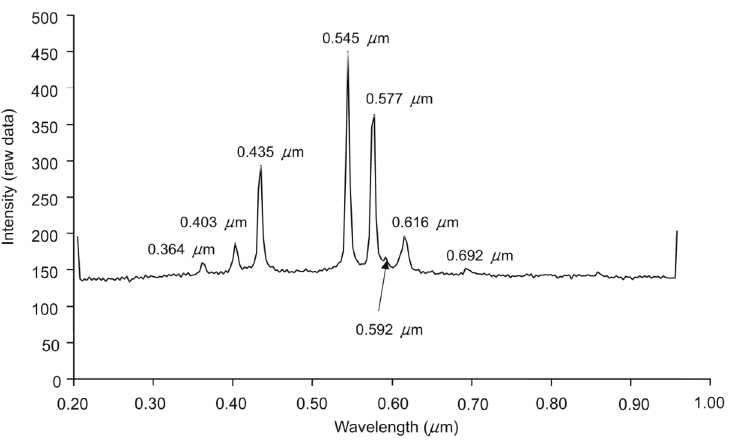
Fig. 1. Uncalibrated spectrum of a standard Hg city lamp emitting white-yellow light. Let us note the funda- mental characteristic of this source, which emits radiation in discrete wavelength ranges (spectral lines) associ- ated to transitions between couples of electronic states. Typical mercury spectral emission lines are recognised. Data were acquired by a portable spectro-radiometer developed by us.